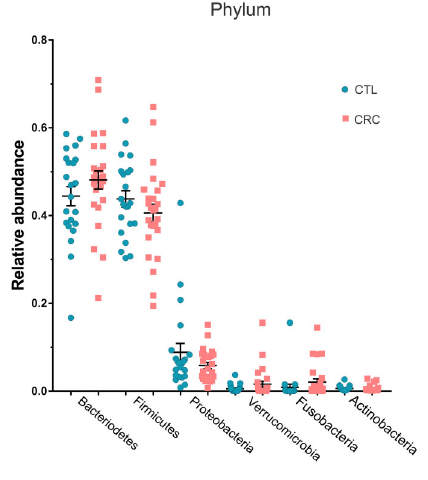
Figure 2. Relative abundance of bacterial phyla. Comparison of metagenomics analysis of bacterial phyla from gut microbiota in colorectal adenocarcinoma (CRC) patients (n=28) and control (CTL) subjects (n=23). The data were obtained from sequencing of the hyper-variable region (V3-V4) of the bacterial 16S rRNA gene. Points represent the relative abundance of each participant.